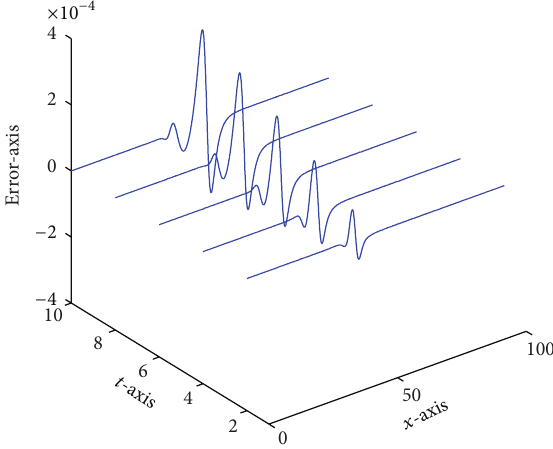
Figure 1: Solitary wave with 𝑐 = 0.05 , ℎ = 0.2 , 𝑘 = 0.2 and 𝑥 0 = 40 , 0 ≤ 𝑥 ≤ 100 .